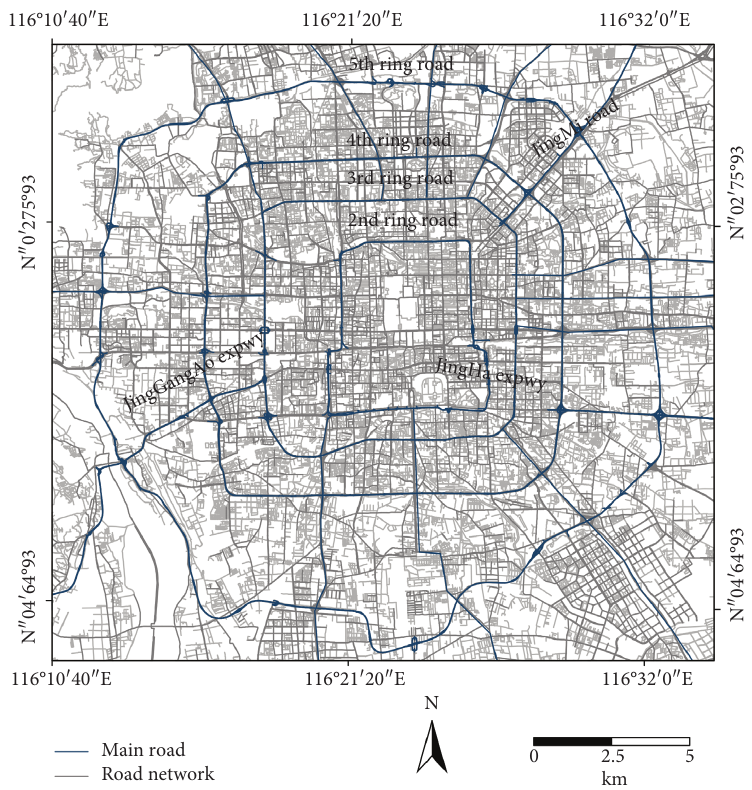
Figure 2: Major road network structure.